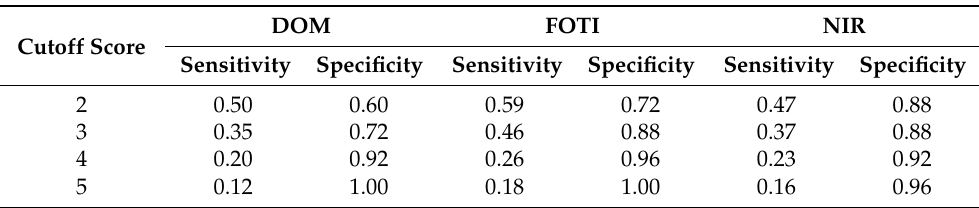
Table 1. Sensitivity and specificity of the applied investigation methods for different cutoff values of the crack depth